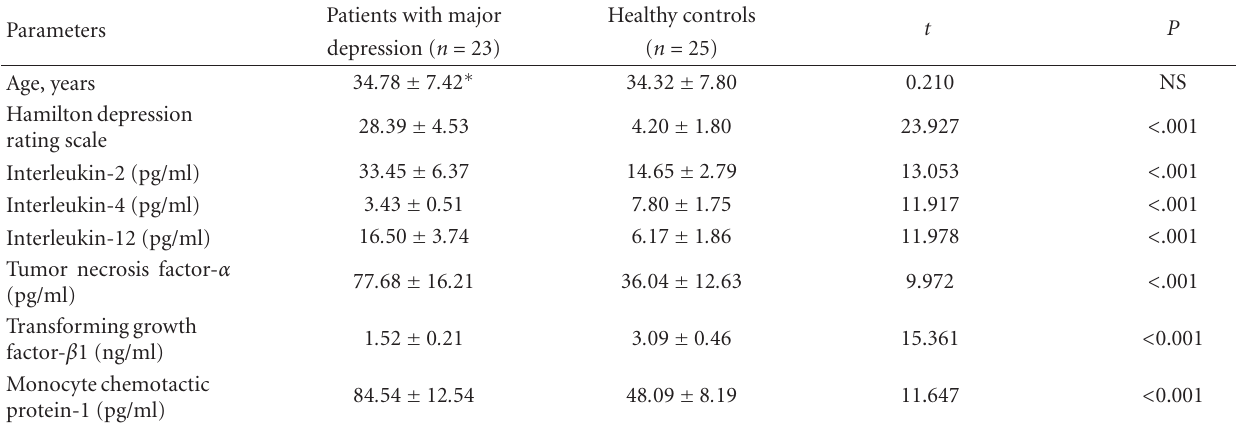
Table 1: Clinical and immunological features in patient and control groups.